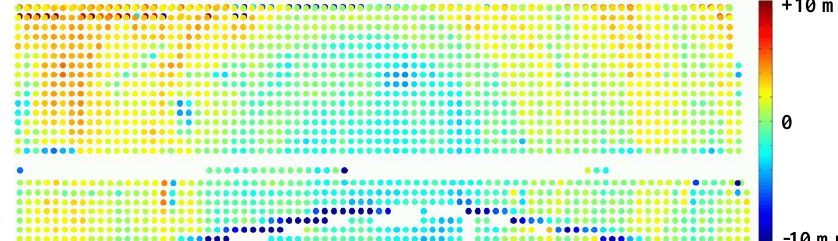
Figure 7: Distance per grid point between points on corresponding segments, after removal of the mean